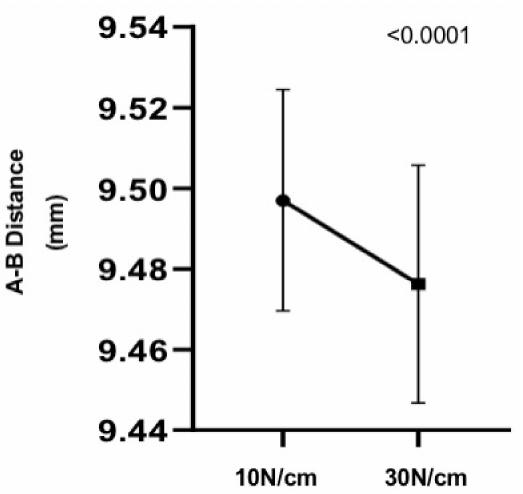
Figure 4. Chart showing a significant decrease in A–B distance between 10 N and 30 N in the pillars on the implants (Group